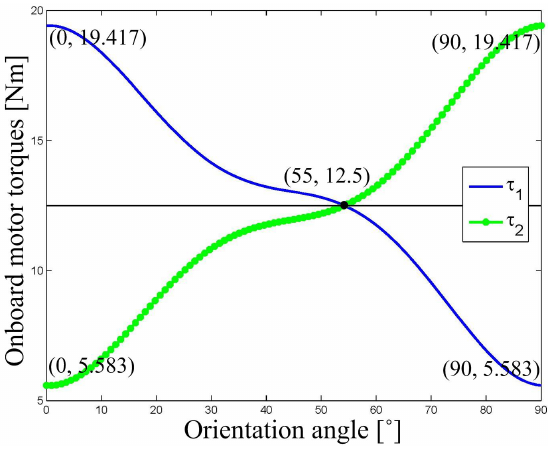
Figure 14. Required motor torques of the DWMR on the Lamé